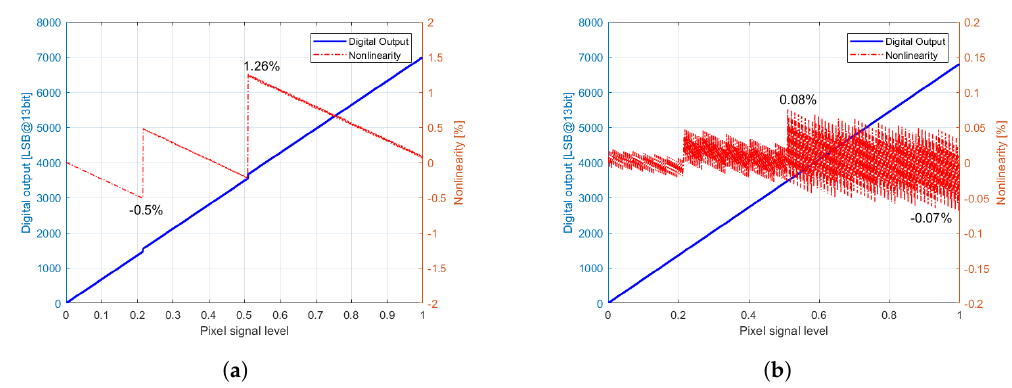
Figure 27. Linearity of the gain-adaptive SS-ADC ( a ) without ( b ) with calibration. Table 2. Performance comparison of the related